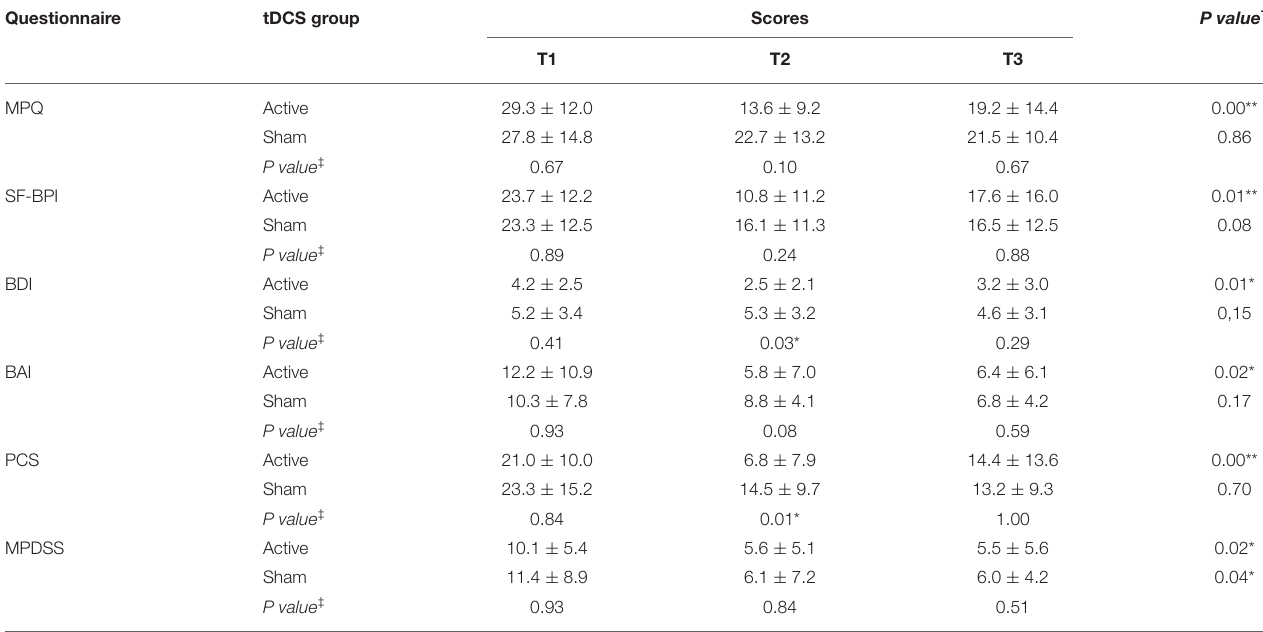
TABLE 2 | Pain-related questionnaires.